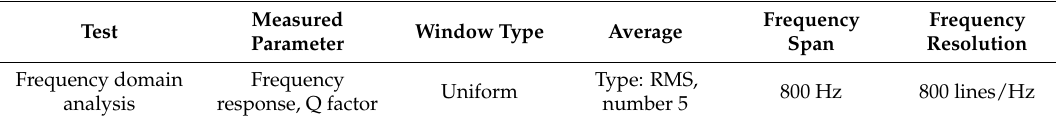
Table 1. Test conditions for the signal analyzer.